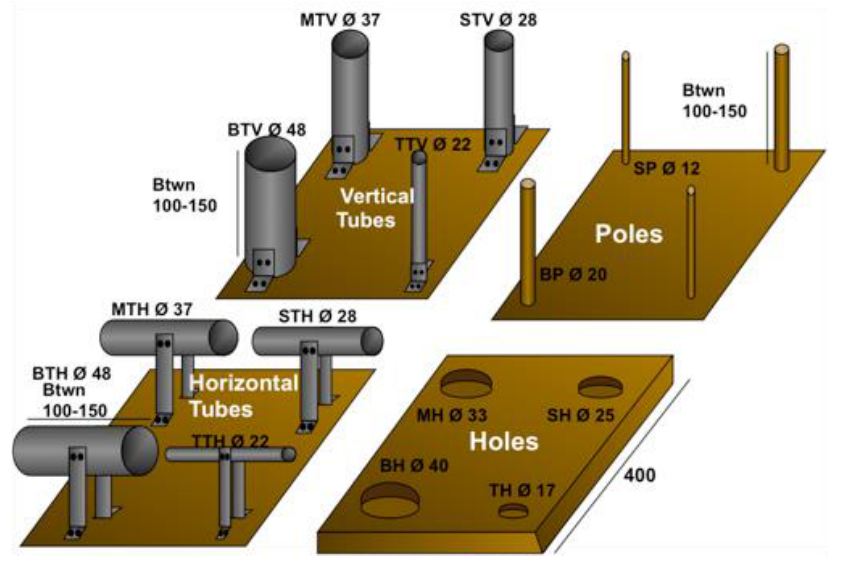
Figure 1 . Activity Plates (dimensions in mm): tubes and poles (length 80, 100 or 150 mm; 100 for Goffins, 150 for kea, BPC); vertical tubes: big tube vertical (BTV), medium tube vertical (MTV), small tube vertical (STV), tiny tube vertical (TTV); horizontal tubes (BTH-TTH); poles (BP & SP); holes (BH-TH). BTH, BTV and BH fit all objects except big rings, MTH, MTV and MH fit all objects except for the big rings cubes and balls, STH, STV and SH fit all objects except for big and medium rings, cubes and balls. TTV, TTH and TH fit sticks from size S2-S5. As in Auersperg et al. (in press), in agreement with the authors of the previous study.